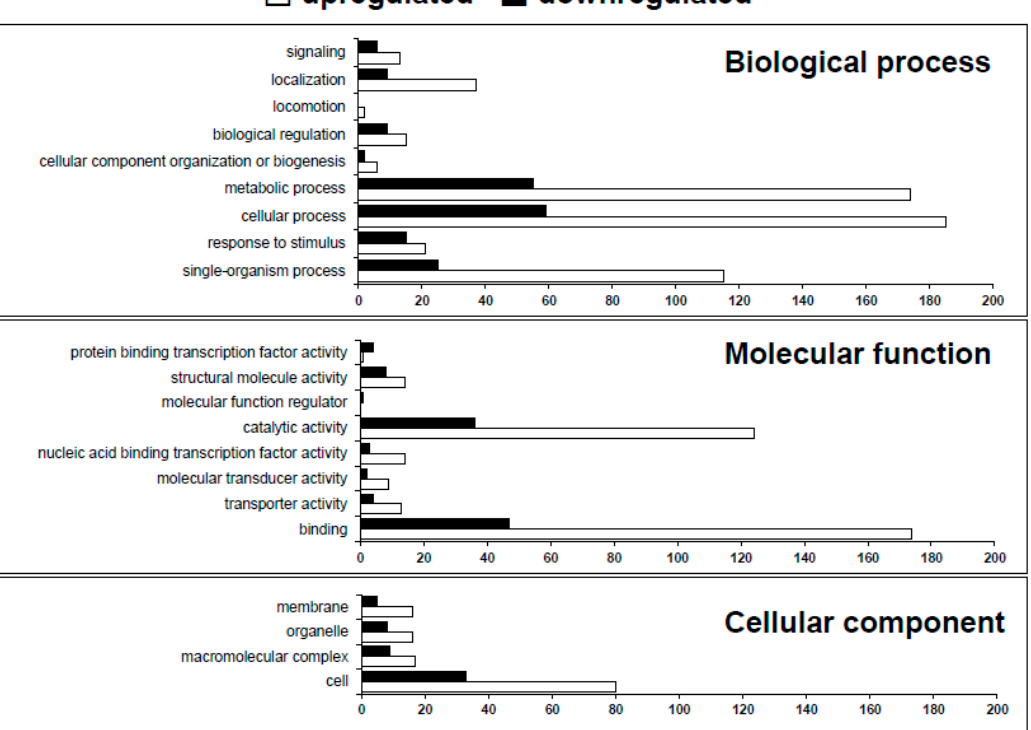
Figure 3. Functional categorization of the upregulated and downregulated genes in Xanthomonas oryzae pv. oryzae HB1009 (K3a race) based on the GO annotation.